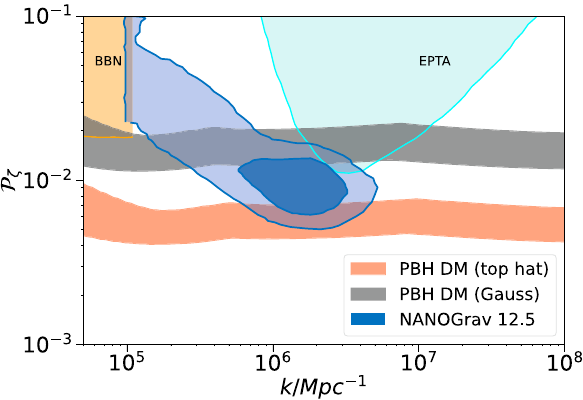
Fig. 7 The constraints on the primordial curvature power spectrum. The orange and cyan regions are excluded by BBN [152] and EPTA [151]. The blue area is the allowed region to explain the NANOGrav 12.5 years data sets; the two contours denote the 1 σ and 2 σ confidence regions, respectively. The black and red bands are the upper limits con- strained from the PBHs observational data, as displayed in the right panel of Fig.